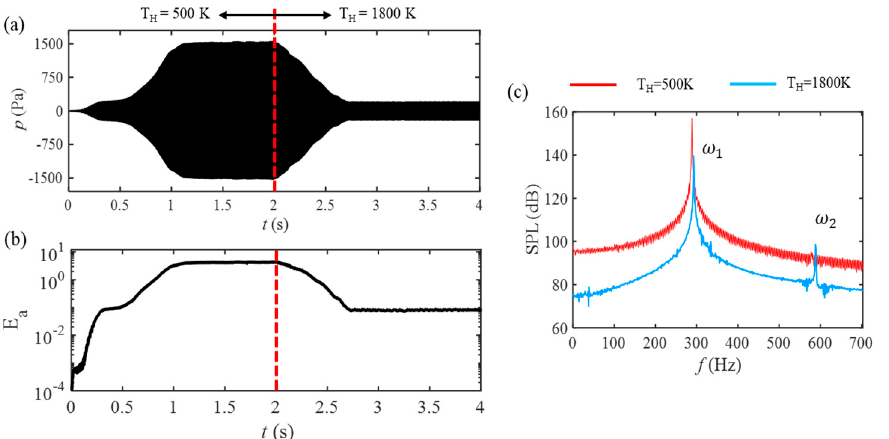
Figure 13. ( a ) Pressure fluctuation in the time domain, ( b ) acoustic energy per unit volume in the time domain, and ( c ) corresponding spectrum of pressure fluctuations, where S N = 0.45, V a = 180 L/min and T i = 300 K.